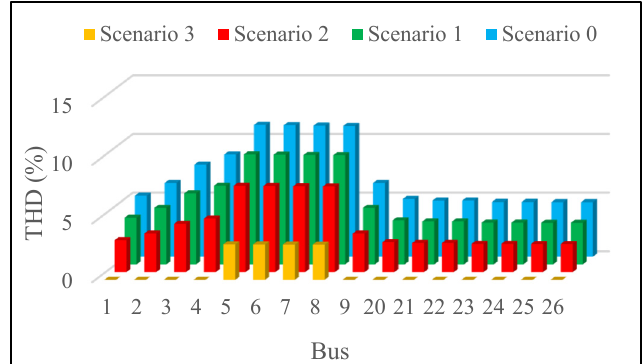
Figure 11. The THD value of the network voltages when the SACAPF is located in bus 4 (scenarios are defined in Table 3).